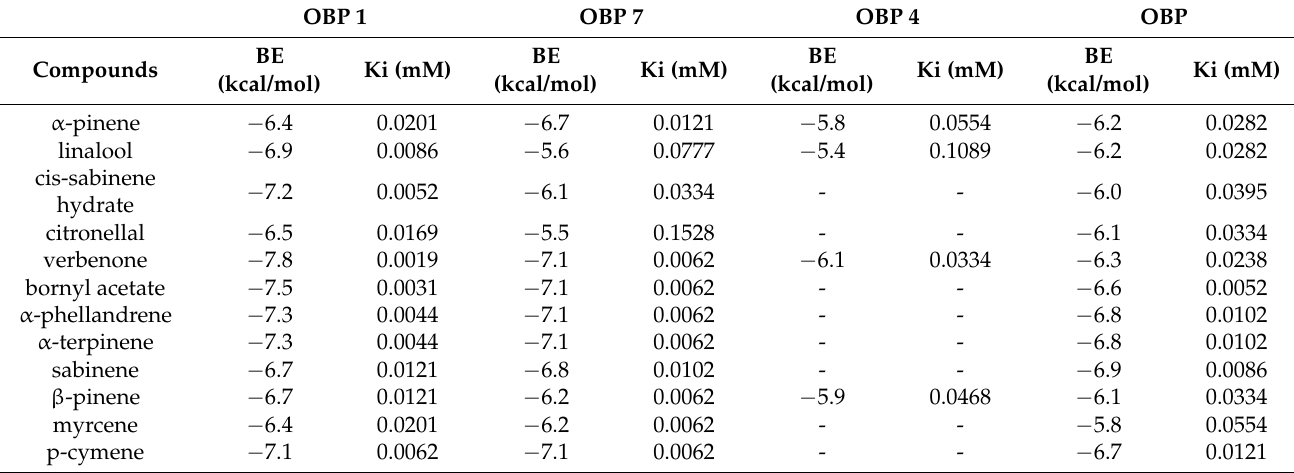
Table 5. Molecular docking results for the interaction between the selected ligands and the odorant binding proteins.